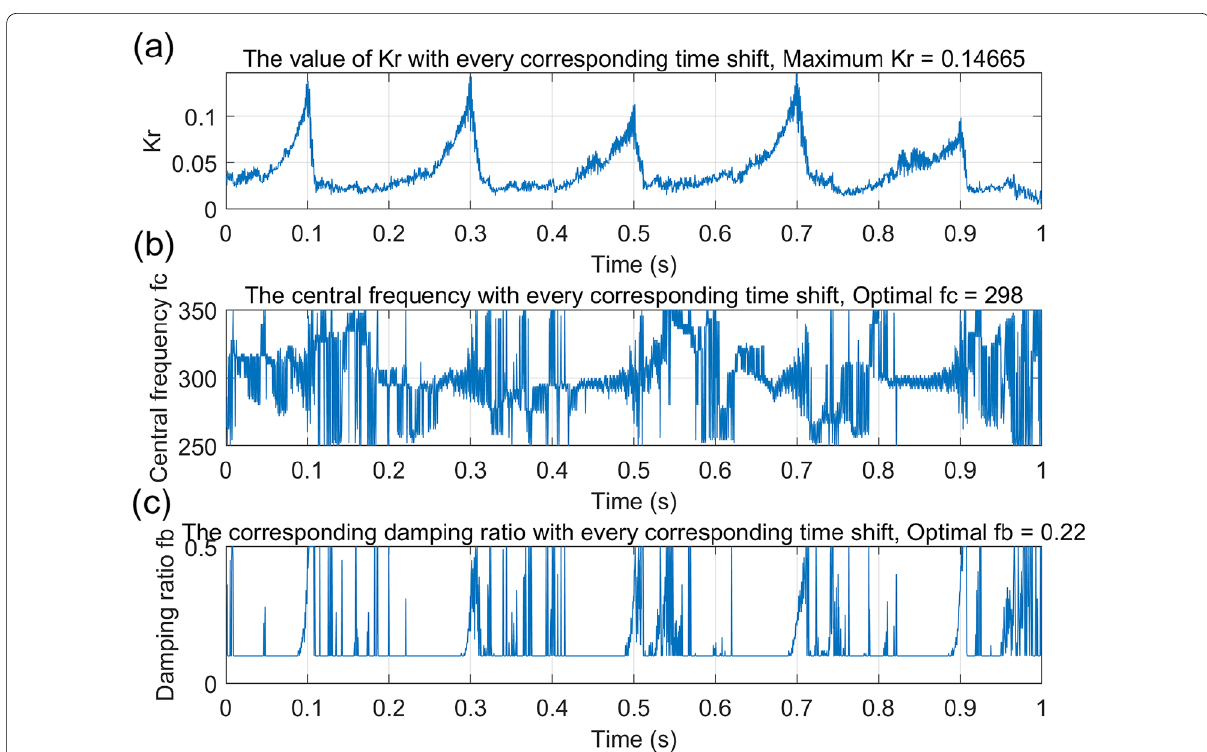
Figure 7 Optimal central frequency and damping ratio obtained by CCM: ( a ) the value of correlation coefficient with every corresponding time shift, ( b ) the central frequency with every corresponding time shift, and ( c ) the damping ratio with every corresponding time